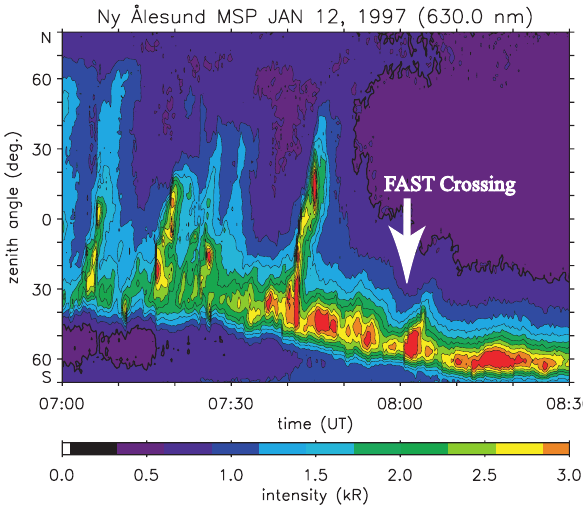
Fig. 3. Color-coded 630nm meridian-scanning photometer intensi- ties from Ny ˚Alesund. The white arrow indicates when the FAST spacecraft was crossing through the cusp